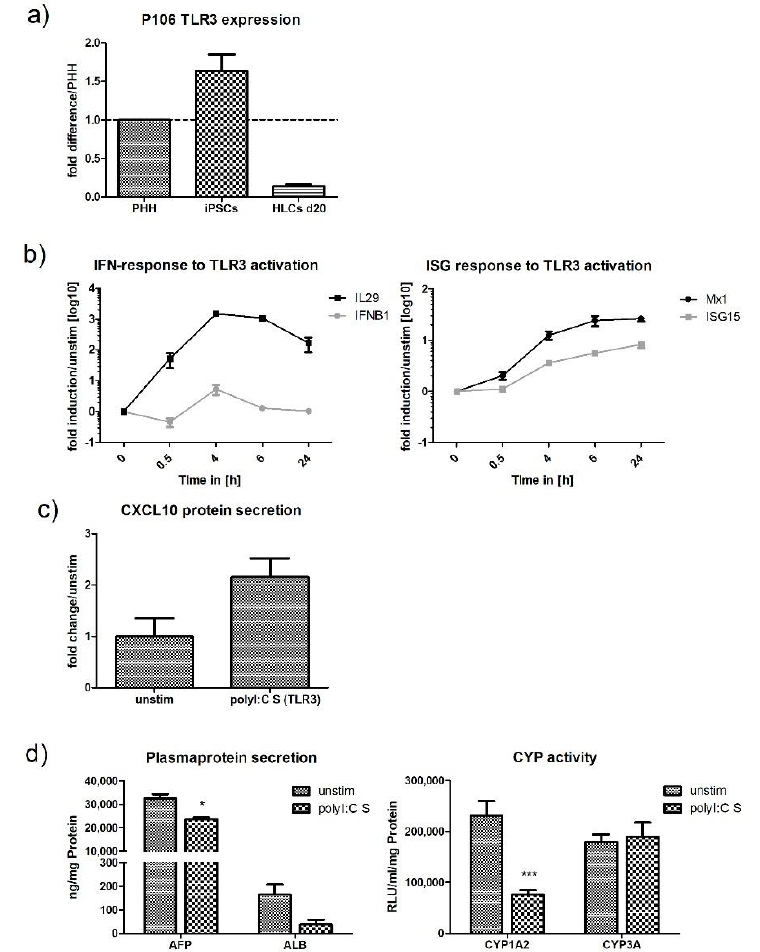
Figure 3. HLCs express low levels of TLR3 but can respond to viral ligand stimulation. ( a ) Comparison of baseline TLR3 mRNA expression in PHH, P106-iPSCs, and P106 HLCs on d20.